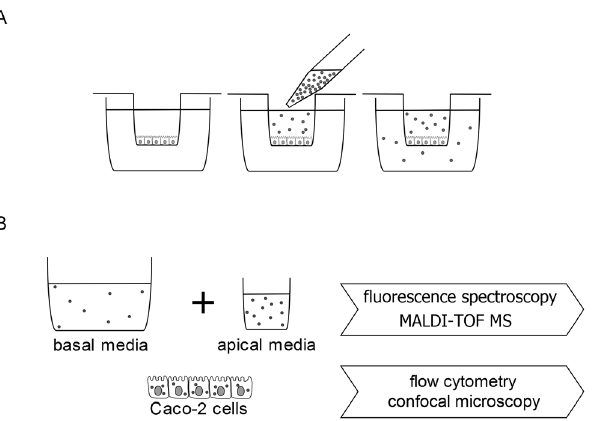
Figure 1. Experimental setup. (A) A differentiated Caco-2 Monolayer was incubated with fluorescence labeled P31–43 or P56–68 on the apical side of the cells. (B) After 3 h or 24 h incubation the apical and basal cell media were analyzed by fluorescence spectroscopy and MALDI-TOF-MS. The Caco-2 cells were analyzed by flow cytometry and confocal